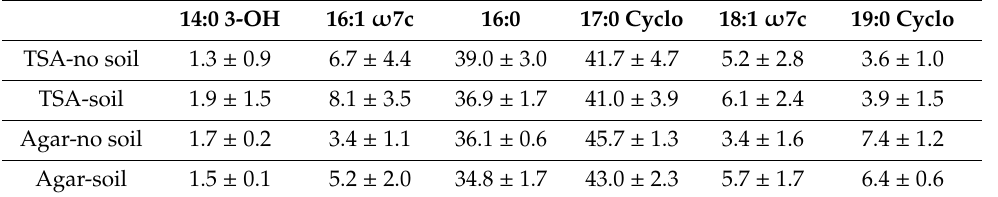
Table 2. Fatty acid profiles of Y. pestis in Tryptic Soy Agar (TSA) and agar. The mean relative abundance of each biomarker is given with one standard deviation ( n = 6 for each culturing